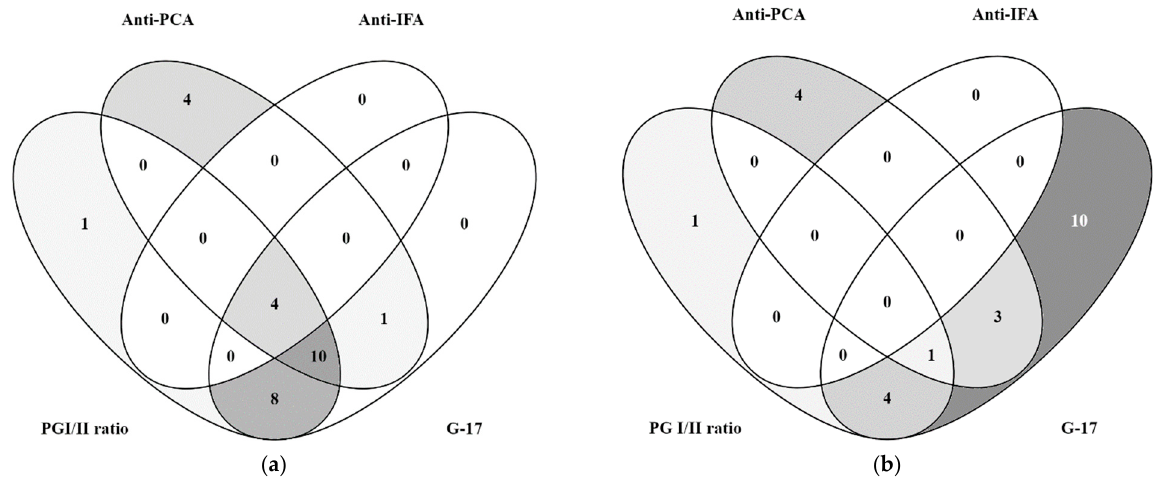
Figure 1. Venn diagrams illustrating patient numbers with positive overlapping biomarker values G-17, PGI/II ratio, anti-PCA, and anti-IFA. ( a ) From 29 CRAG cases, 28 had at least one positive biomarker value. One patient had all values negative. ( b ) From 58 controls, 20 controls had at least one positive biomarker value. Table 6. Pearson correlation coefficients illustrating correlations between biomarker values G-17, PGI/II ratio, anti-PCA, and anti-IFA in all individuals, CRAG cases, and controls a . All Patients ( n = 87) G-17 PGI